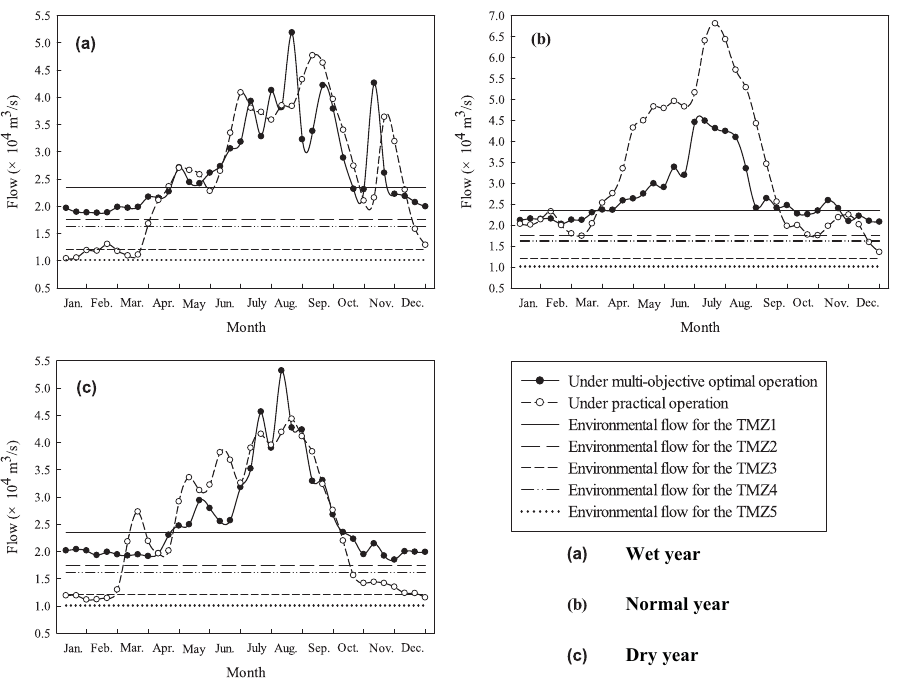
Figure 6. Practical operation and multiobjective-optimized operation results on the downstream Datong cross section and the environmental flows for 5 critical cross sections of the TMZ in the three typical